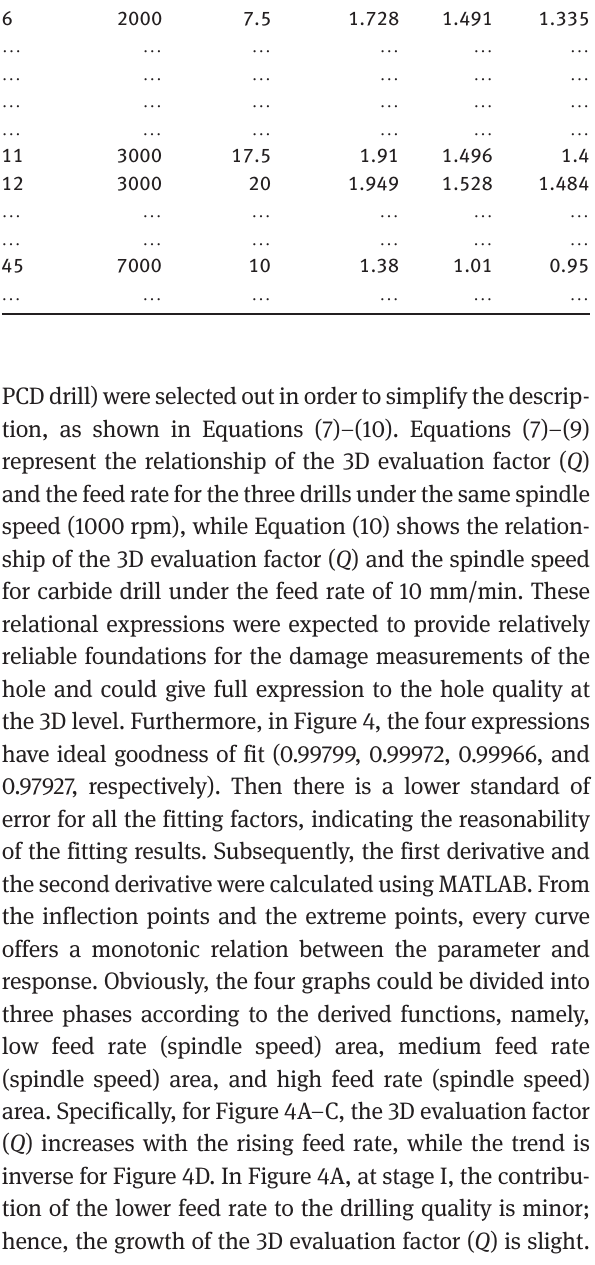
inverse for Figure 4D. In Figure 4A, at stage I, the contribu- tion of the lower feed rate to the drilling quality is minor; hence, the growth of the 3D evaluation factor ( Q ) is slight.